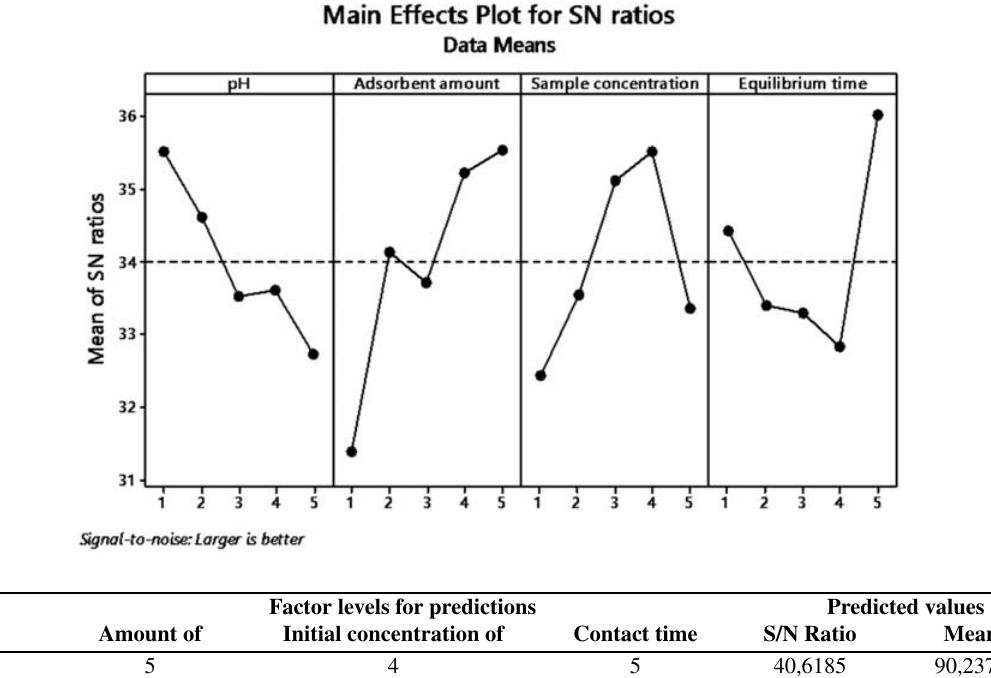
Figure 1. Main effects plot for SN ratios, Factor levels for predictions, Predicted